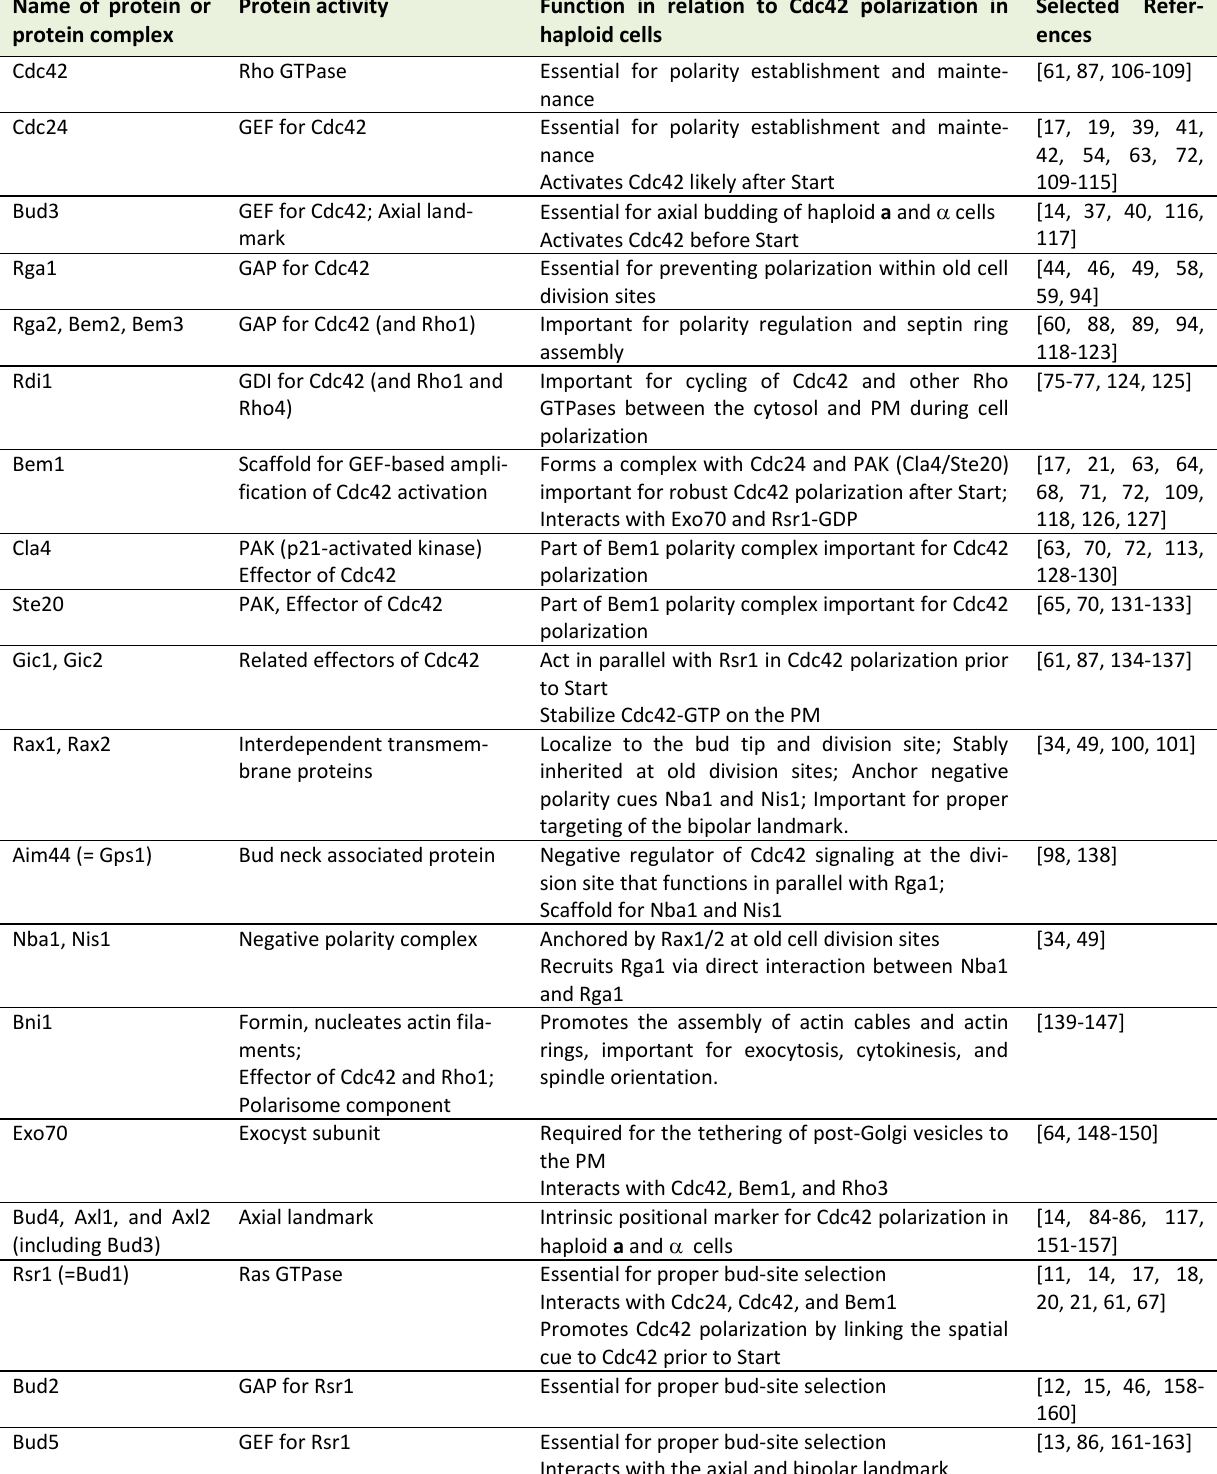
TABLE 1. The Cdc42 and Rsr1 GTPses and their regulators and effectors. Name of protein